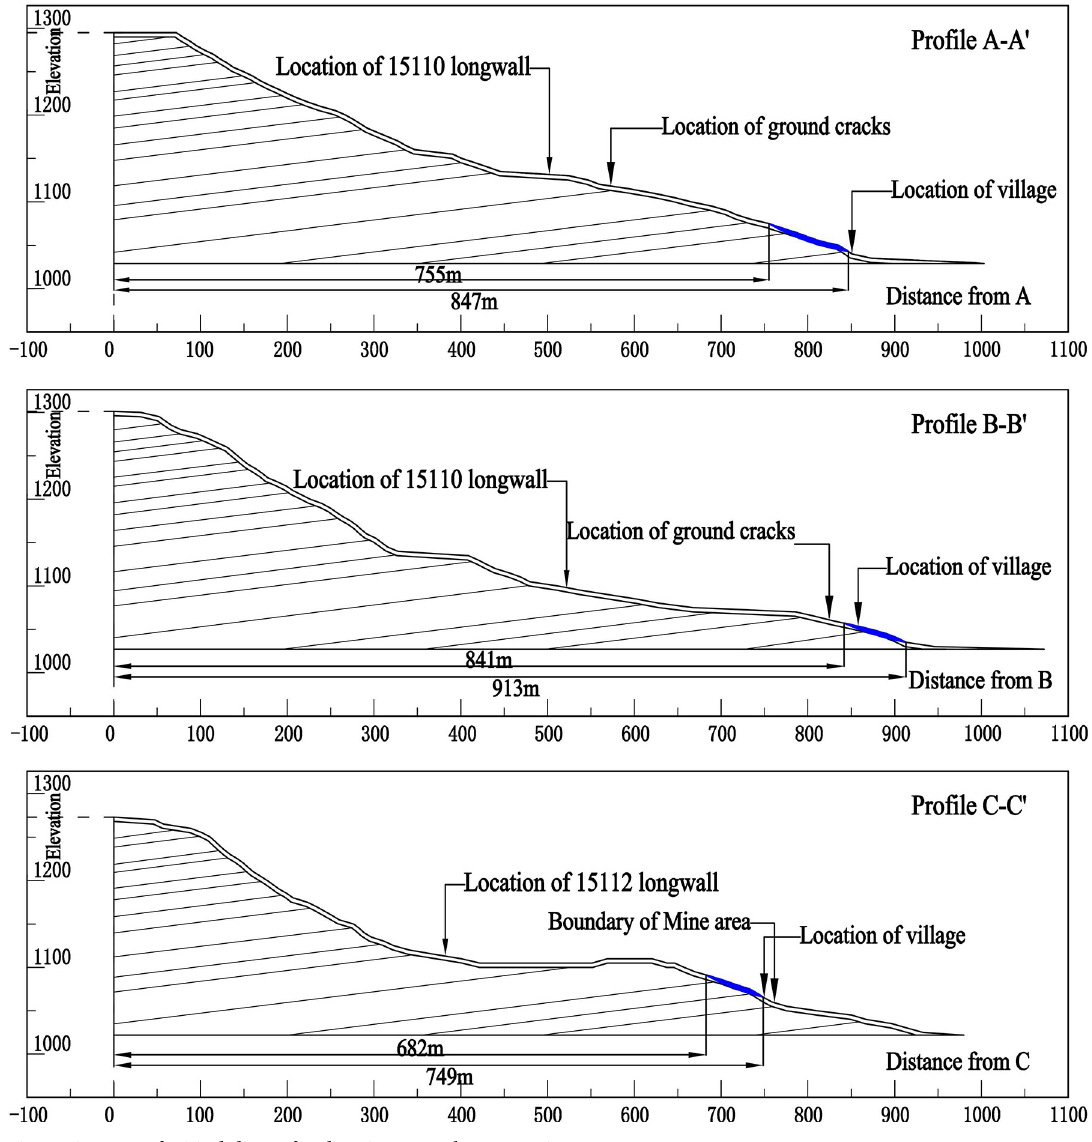
Fig 7. Diagrams of critical slip surface locations at each cross section.